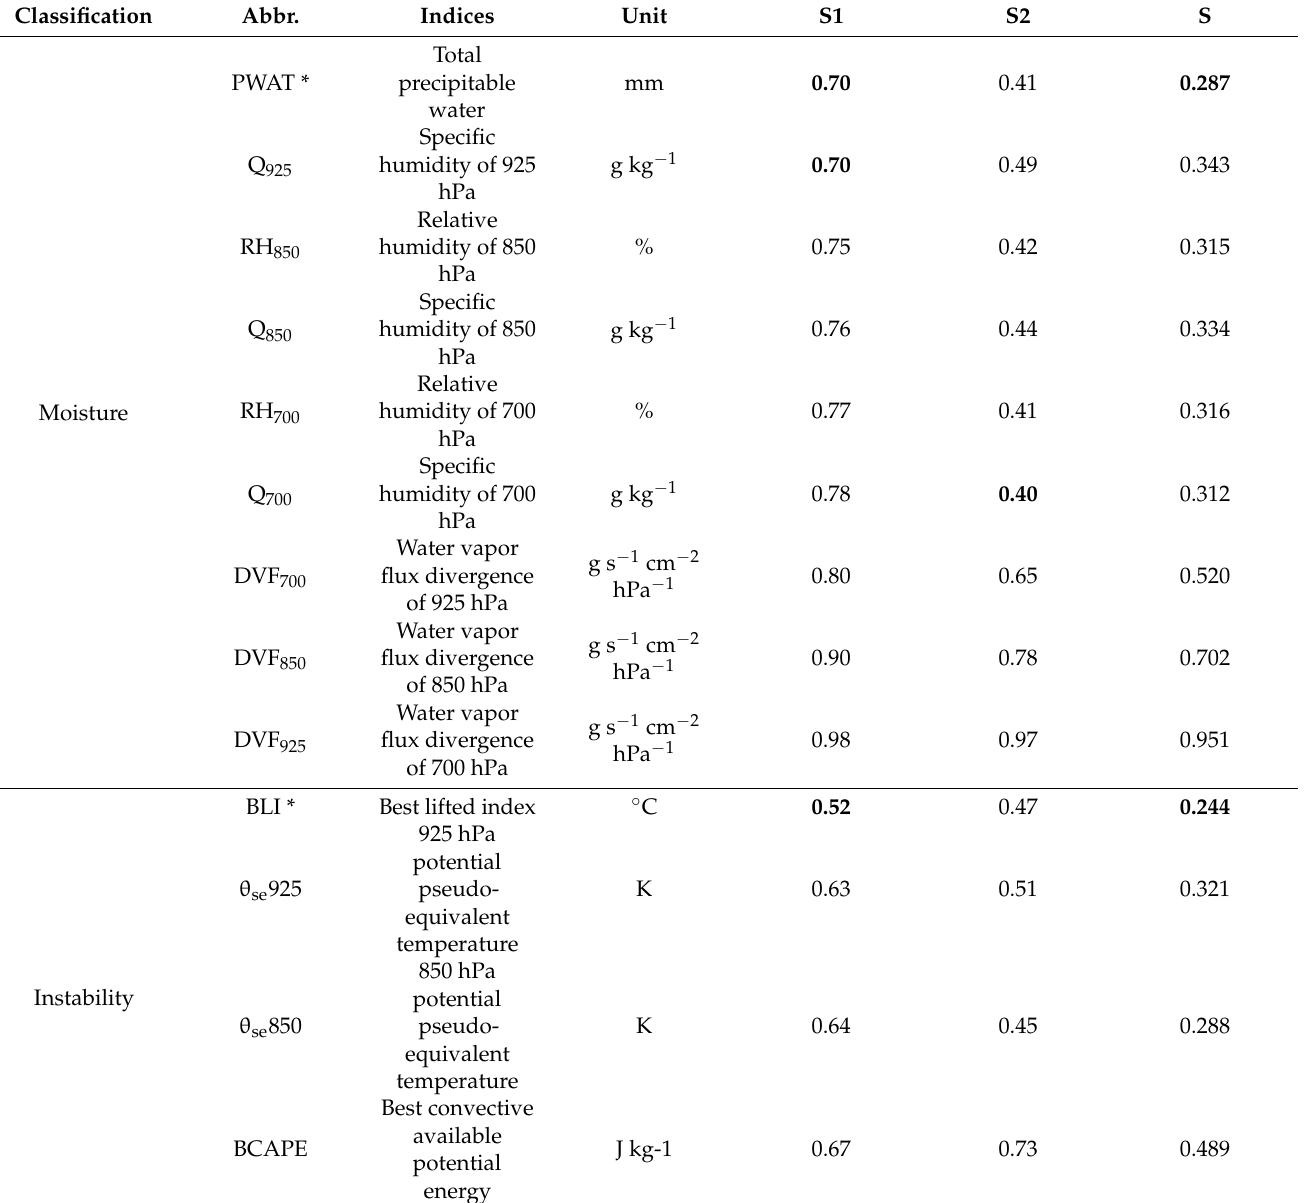
Table 1. Description of referred parameters used to indicate the environmental moisture content, instability, and lifting conditions. S1 and S2 represent the overlapping sizes of the relative frequencies between SDHR and ordinary rainfall (S1), and SDHR and no rainfall (S2). S is the multiplication of S1 and S2. The bolded are the minimum values within its group. The parameters selected as predictors are signed with